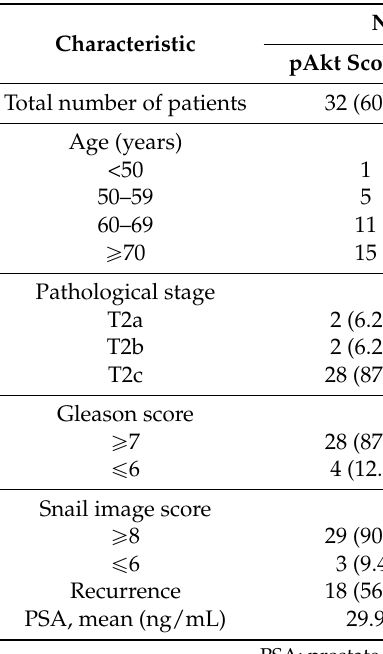
Table 2. The association of phosphorylated (p)-Akt staining and clinicopathological features of prostate cancer (PCa) patients.